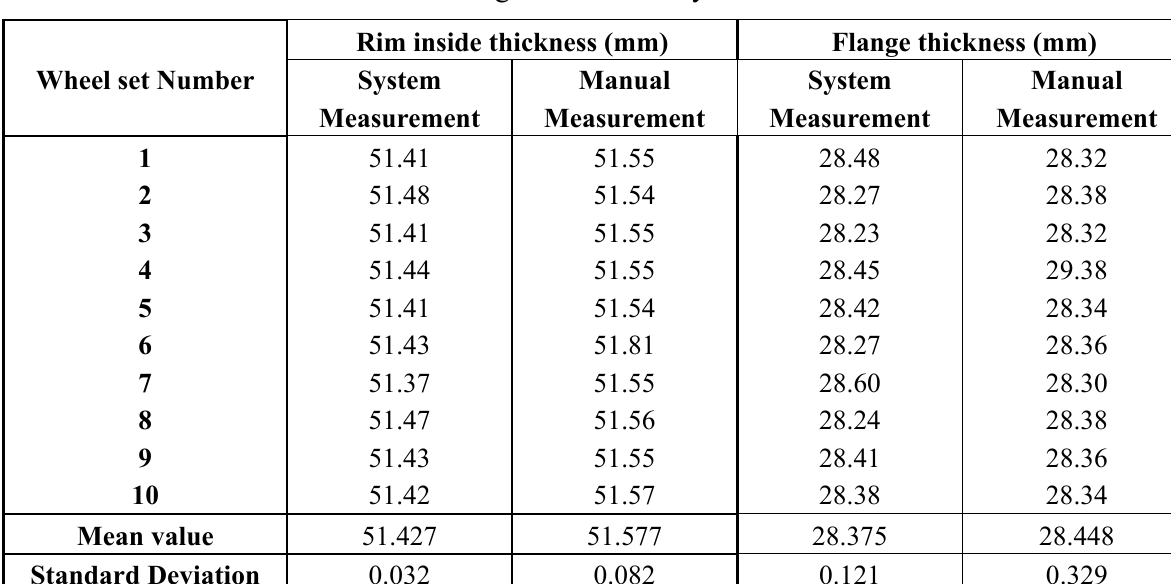
Table 3. measuring results of the system and